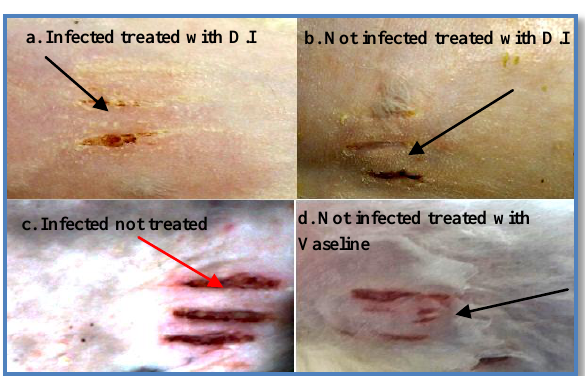
Figure, 2: Day 14 treated with Tetracycline a. (Black arrow) Scar formation with redness of wound. b. (Black arrow) Detached scar without inflammation. c. (Black arrow) Scar formation with redness of wound. b. (Black arrow) Scar with redness of wound.